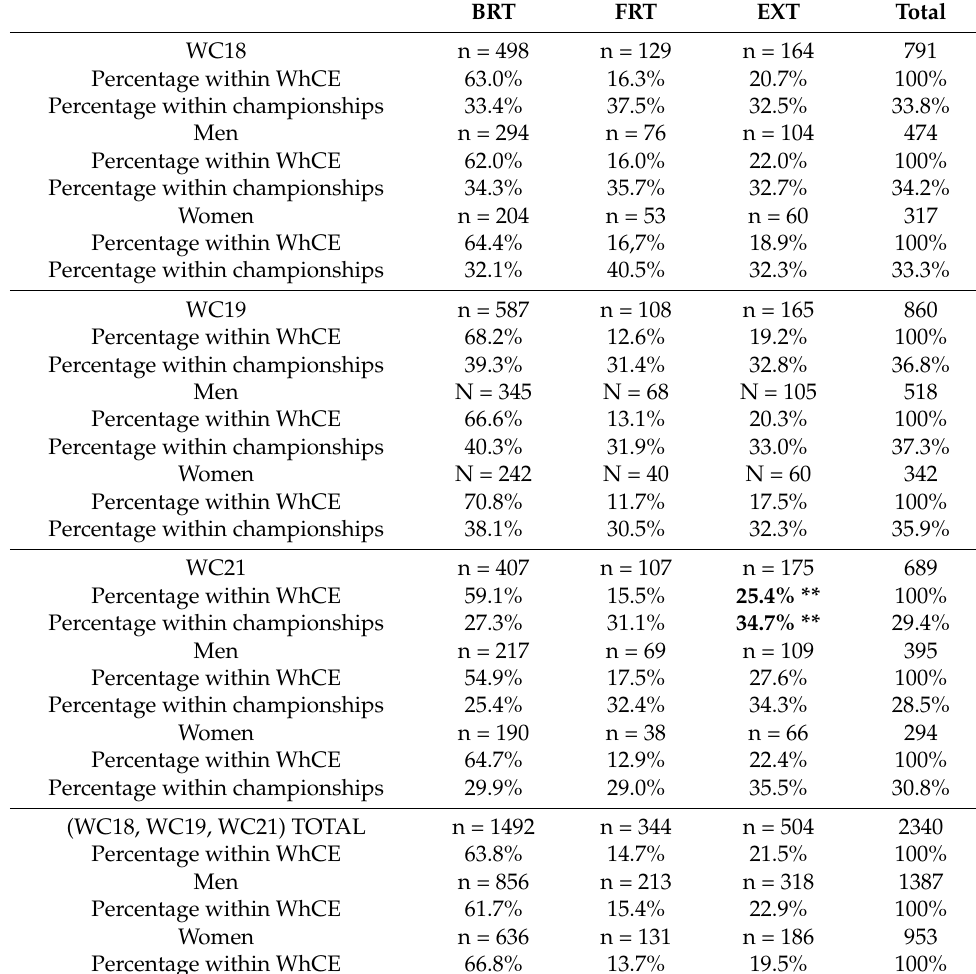
Table 2. Relation between WhCE (contests ending before the accomplishment of the regular time of 4 m (BRT), finishing at the regular time of 4 min (FRT) and finishing during the golden score period (EXT) and the championship analysed (WC18, WC19 and WC21) (n = 2340